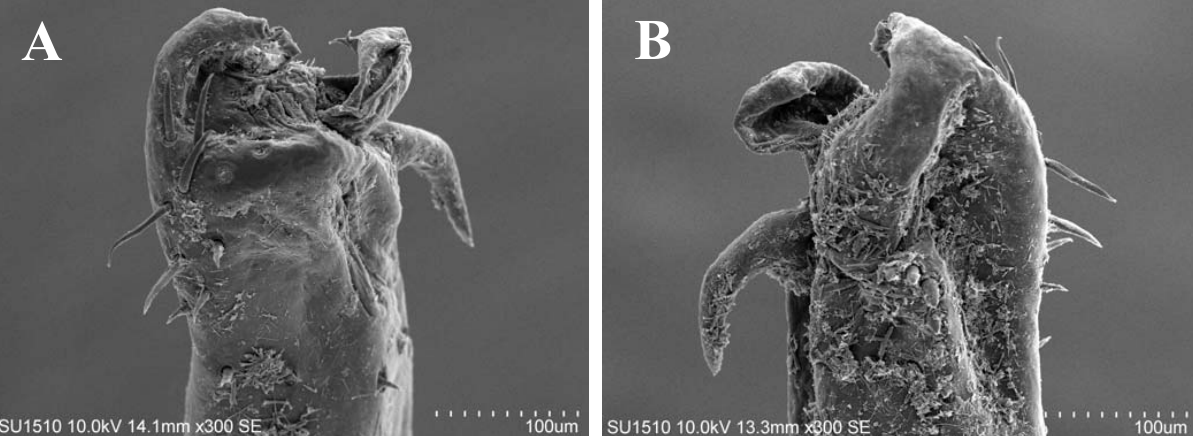
Figure 3. Malacoplax californiensis (male, CW 11.9 mm). SEM photographs. A. Tip of first gonopod, frontal. B. Same, caudal